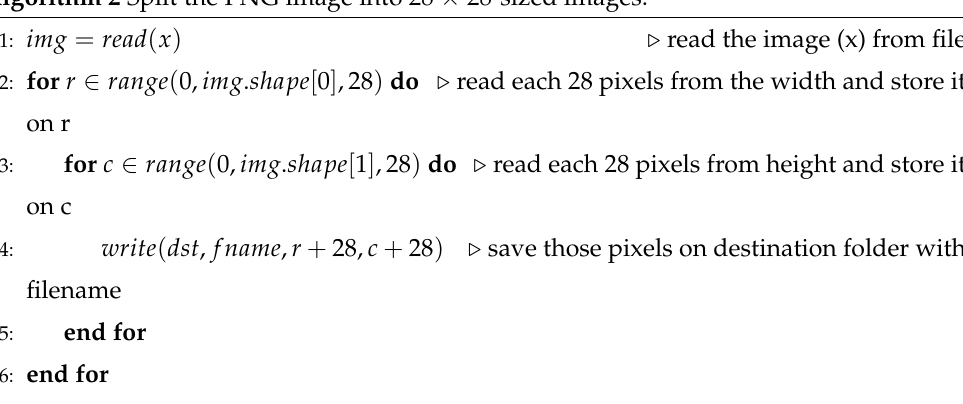
Algorithm 2 Split the PNG image into 28 × 28-sized